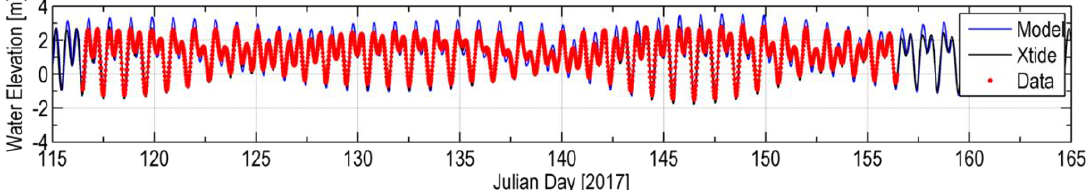
Figure 6. Time series of model result, NOAA harmonic (Xtide) prediction, and observed data for sea-water elevation. Time is shown as Julian days in 2017.